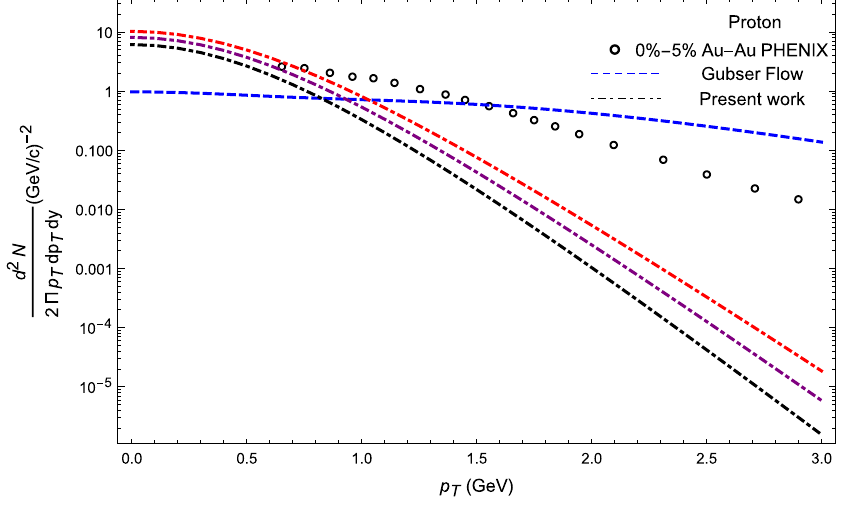
spectrum from central Au-Au collisions: black, purple and red lines correspond to a freeze out temperature of 140, 150 and 160 MeV, respectively. Circles: PHENIX data